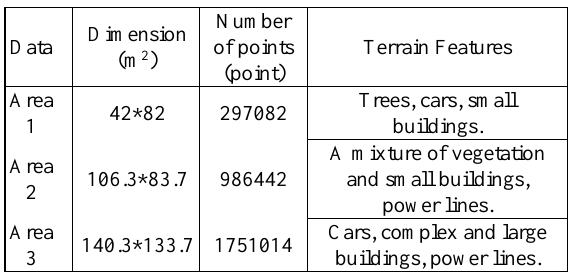
Table 1 . Characteristics of the studied areas.